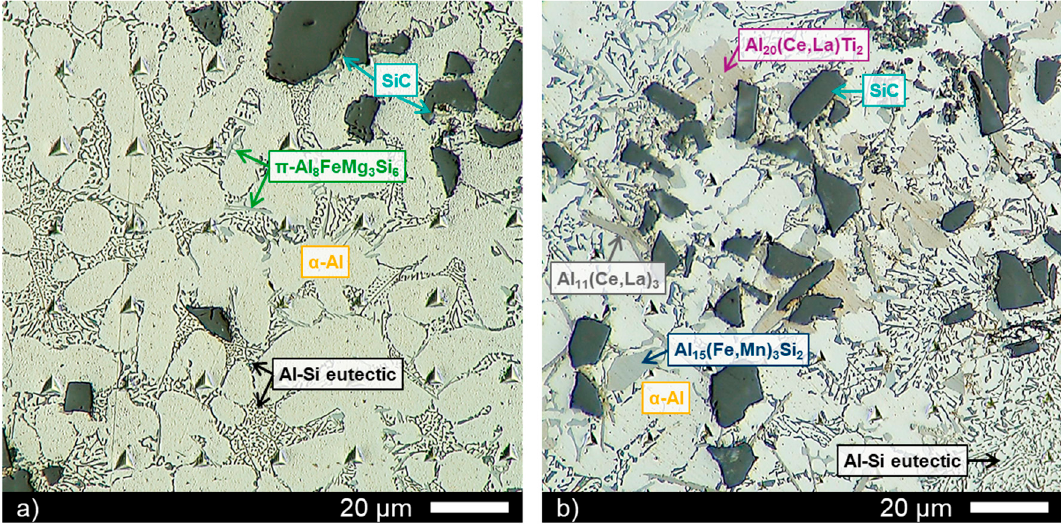
Figure 3. Optical microscope micrographs: ( a ) Material C0; ( b ) Material C1.